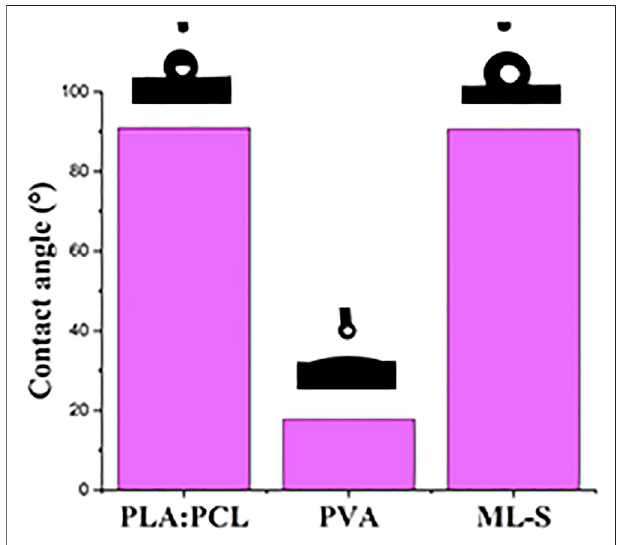
FIGURE 6 | Water contact angle of PLA:PCL, PVA, and